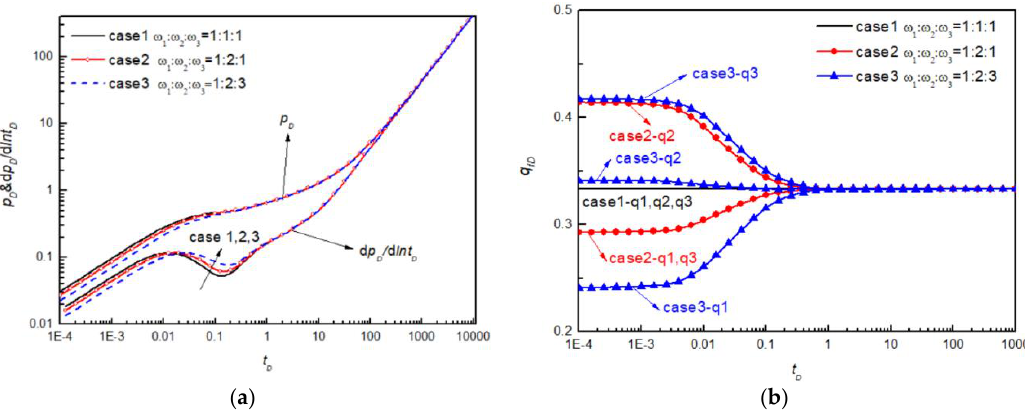
Figure 7. Pressure response and flux distribution of different elastic storage ratio. ( a ) Pressure and pressure derivative; ( b ) Flux distribution of each hydraulic fracture.